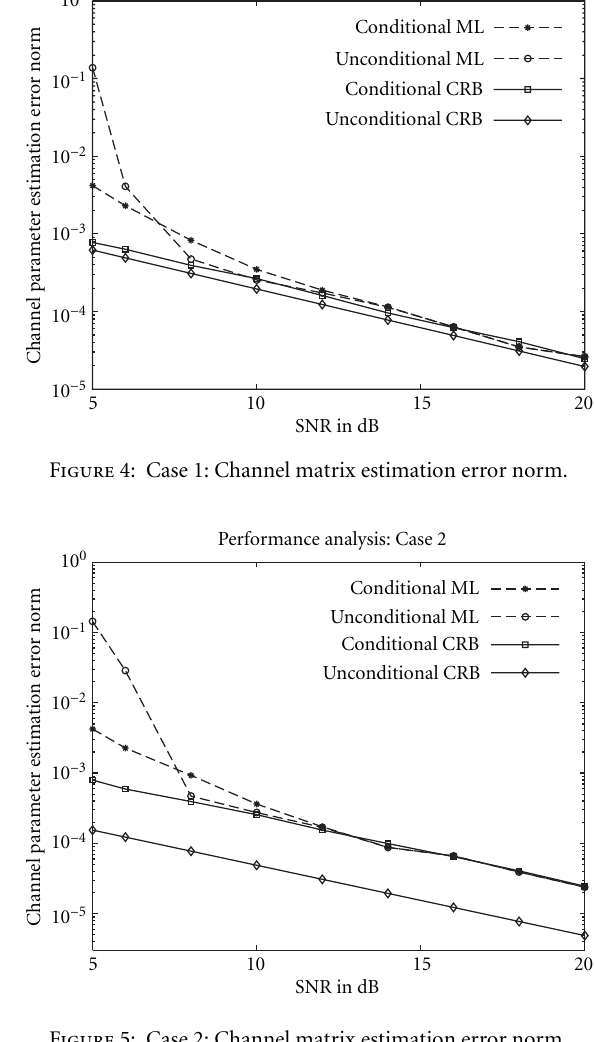
Figure 5: Case 2: Channel matrix estimation error norm.